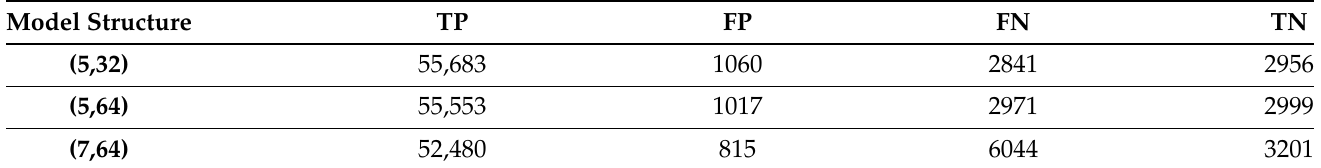
Table 10. The confusion matrix of the best performing model for each configuration. Positive label indicates attack sample Model